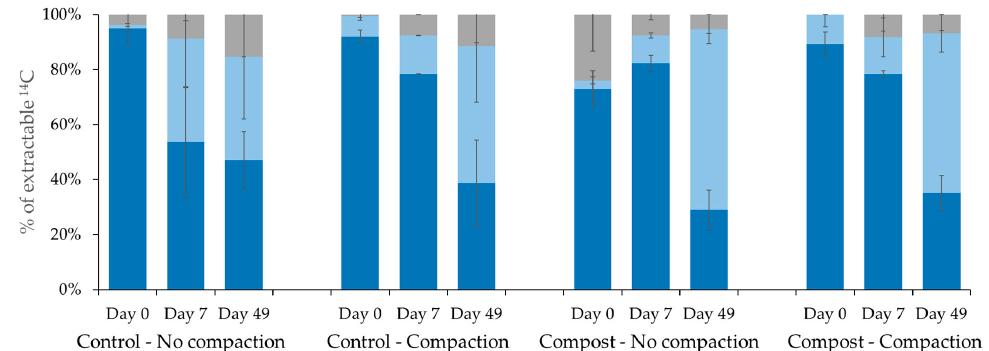
Figure 3. Chromatographic analysis of combined CaCl 2 and CH 3 OH extracts after 0, 7 and 49 days in control (unamended) and compost amended soils, not compacted and compacted: Isoproturon; Monodemethyl ‐ isoproturon; Other metabolites.